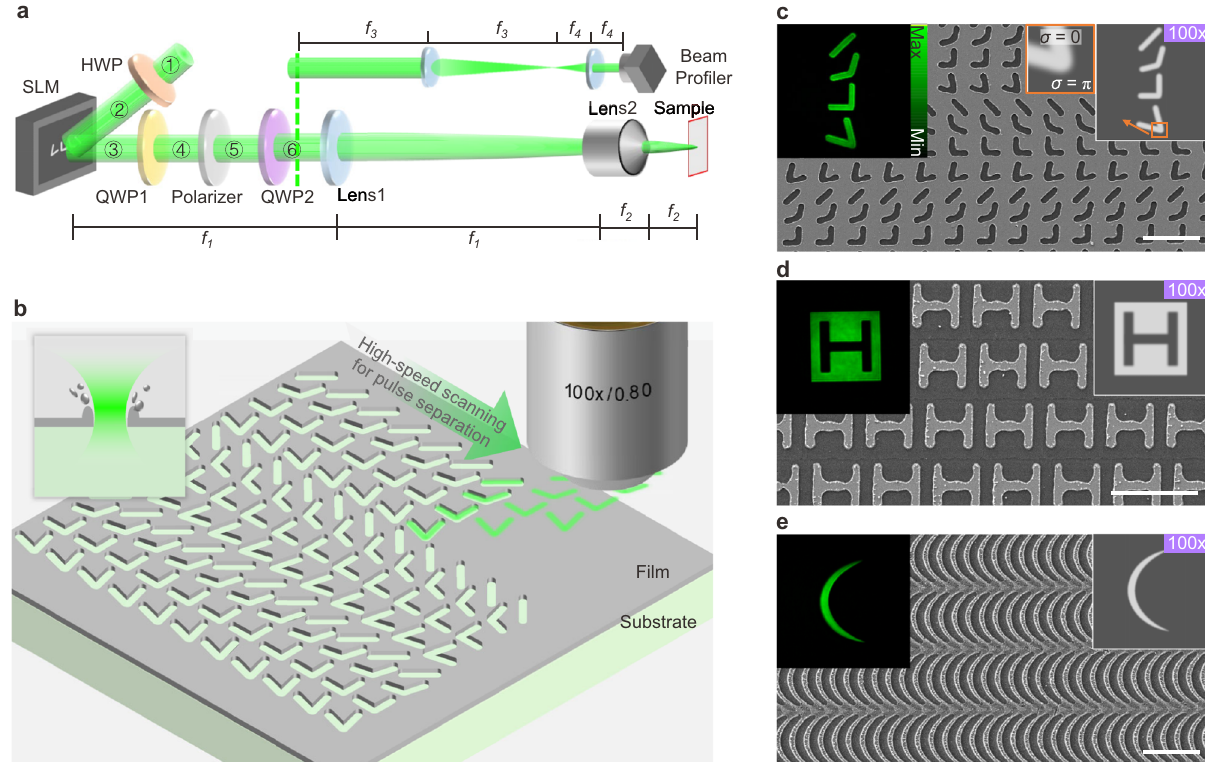
Fig.1|Schematicsofthepatternedpulselaserlithography(PPLL)processand the scanning electron microscopy (SEM) images of the results. a The PPLL system(HWP:halfwaveplate,QWP:quarterwaveplate, f 1 =1000mm, f 2 =2mmfor lens2 of 100× objective or 4mm for lens2 of 50× objective, f 3 =500mm, f 4 =10mm). b Schematic of high-speed scanning and separated pulse ablation for PPLL. c , d , e The quasi-binary phase masks on SLM (right up corner) with